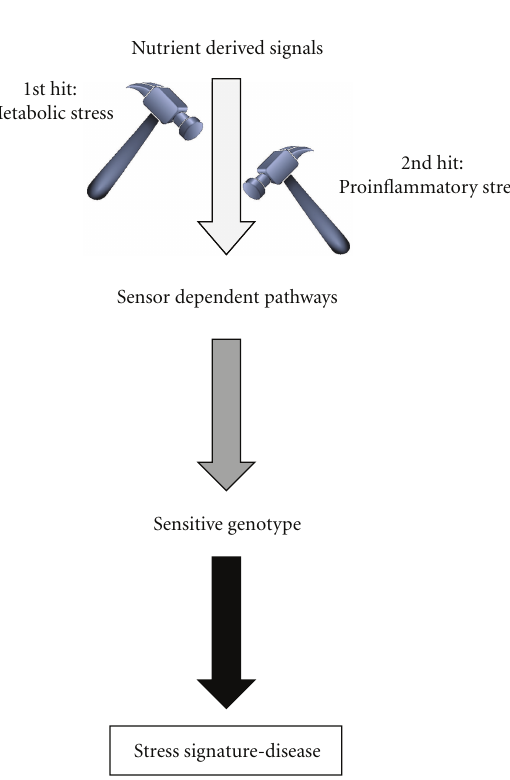
Figure 6: The basic idea with nutrigenomics is to determine a patient’s polymorphisms and formulate a diet that ameliorates these genetic factors to minimum, regulating and maintaining weight